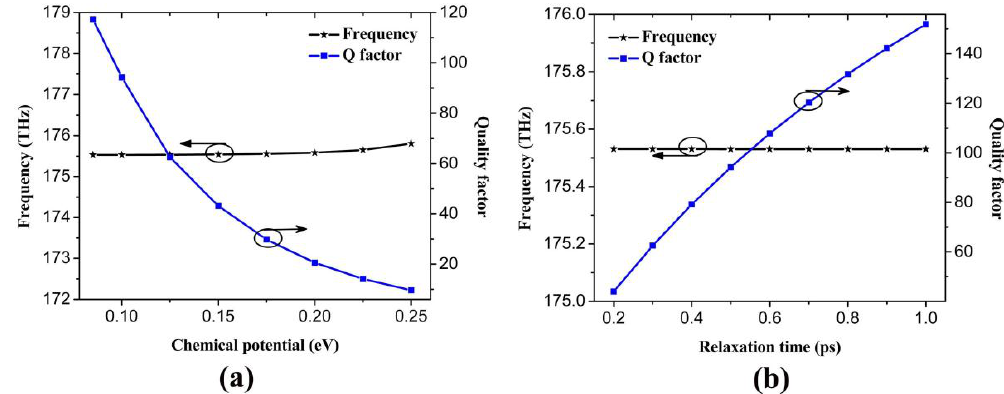
Figure 9. ( a ) Resonant frequency and Q factor as a function of chemical potential of the point defect in 2D PhC, where μ c3 is from 0.085 eV to 0.25 eV with μ c1 = 0.6 eV, μ c2 = 0.9 eV; ( b ) Resonant frequency and Q factor as a function of relaxation time with μ c1 = 0.6 eV, μ c2 = 0.9 eV, μ c3 = 0.1 eV.